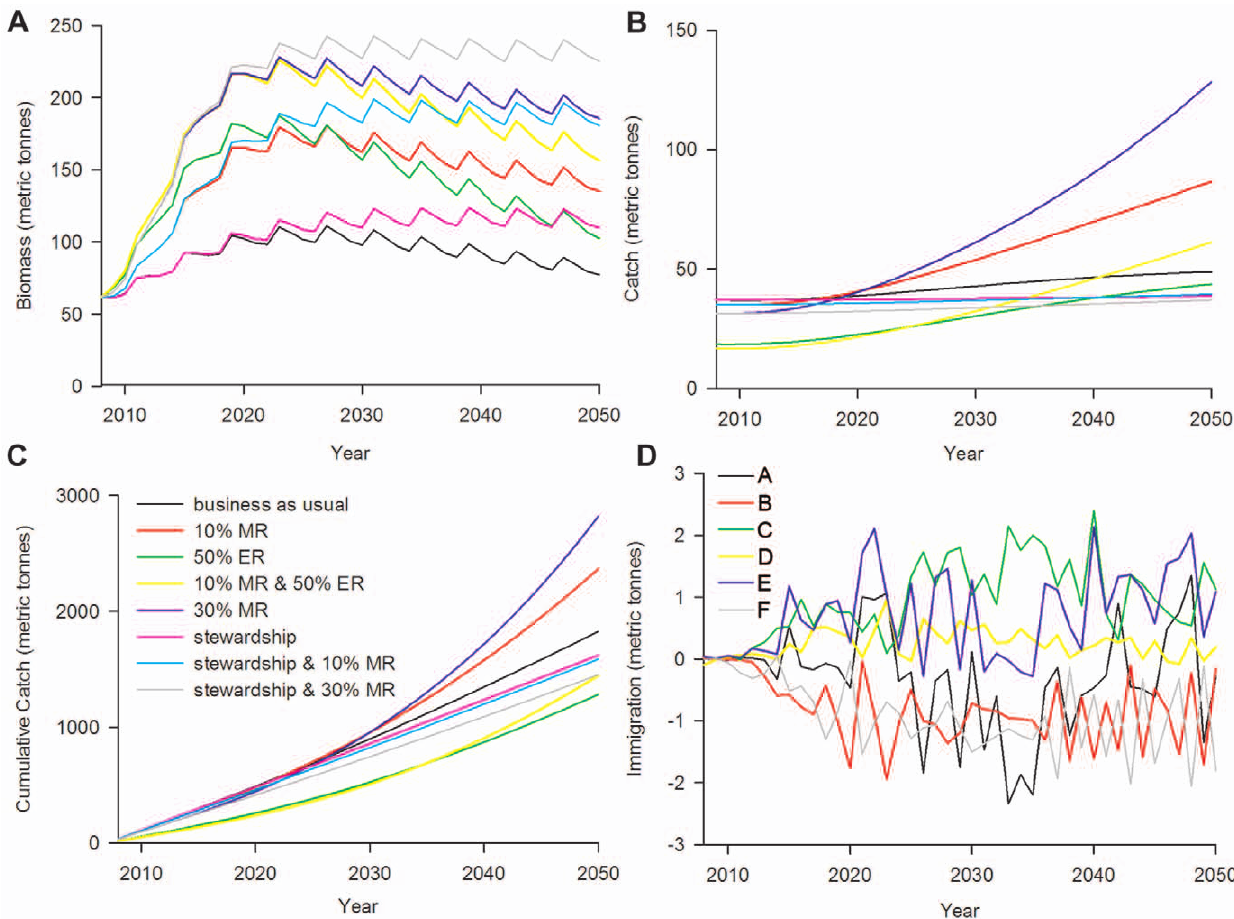
Figure 6. Predicted model results under different management scenarios. A - Predicted lobster biomass within the Juan Ferna´ndez archipelago for differing management and conservation strategies for the ‘future of fishing’ period from 2008–2050. B - Predicted model results for lobster catch in the Juan Ferna´ndez archipelago under different management and conservation strategies for the ‘future of fishing’ period from 2008–2050. C - Cumulative catch from 2008–2050 predicted from the ‘future of fishing’ model for differing management scenarios. D - Predicted lobster spillover by the ‘30% MR’ scenario from the ‘future of fishing’ model. Graph depicts change in population due to spillover in each region (measured as net change in population; positive values correspond to net immigration and negative values to net emigration). Regions A, B and F are closed to fishing with region A located in between regions B & F (see Figure 3 for map). Regions C and E are adjacent to areas closed to fishing, whereas region D does not share a boundary with a closed area (Figure 3).